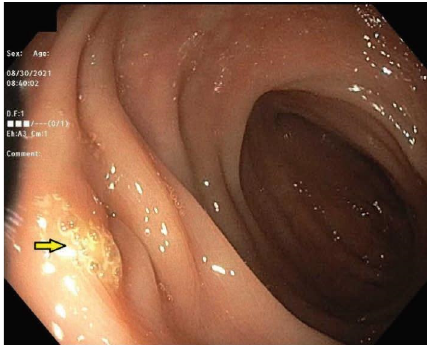
Figure 2: Endoscopic image of an area of indurated tissue 20cm from the anal verge concerning the